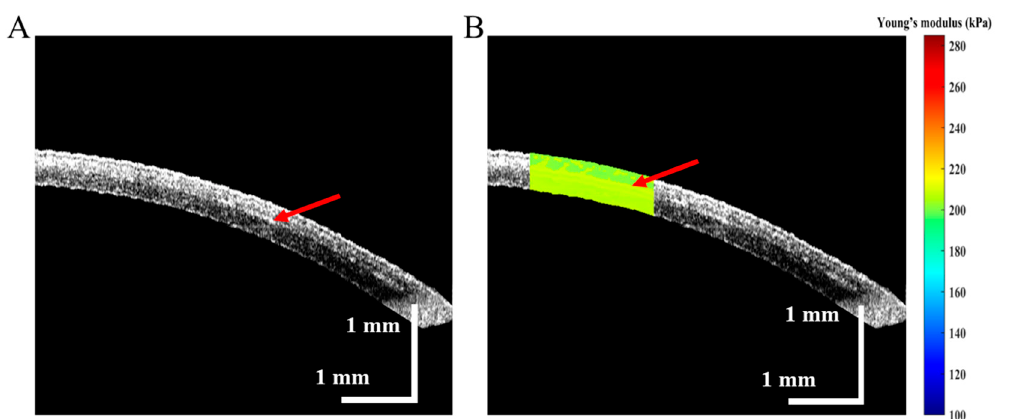
Figure 5. OCE results of cornea after -3D SMILE surgery, ( A ) is the 2D structure image and red arrow mark the boundary of the corneal cap and RSB, ( B ) is the depth-resolved Young’s modulus distribution of cornea, and the red arrow marks the distinct difference in Young’s modulus between the corneal cap and RSB. the corneal cap and